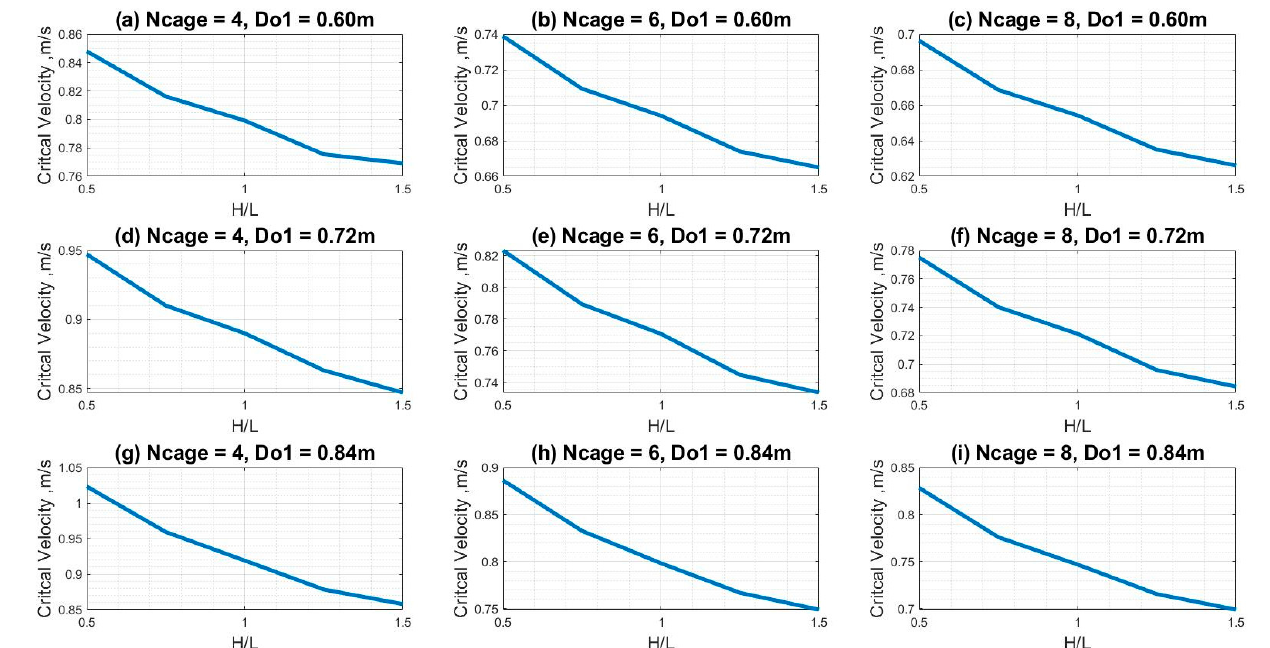
Figure 12. The critical buckling velocity for the Drift State as a function of the cage dimension ratio H/L for combinations of N Cage and D O 1 : ( a ) N Cage = 4, D O 1 = 0.6, ( b ) N Cage = 6, D O 1 = 0.6, ( c ) N Cage = 8, D O 1 = 0.6, ( d ) N Cage = 4, D O 1 = 0.72, ( e ) N Cage = 6, D O 1 = 0.72, ( f ) N Cage = 8 , D O 1 = 0.72, ( g ) N Cage = 4, D O 1 = 0.84, ( h ) N Cage = 6, D O 1 = 0.84, ( i ) N Cage = 8, D O 1 =